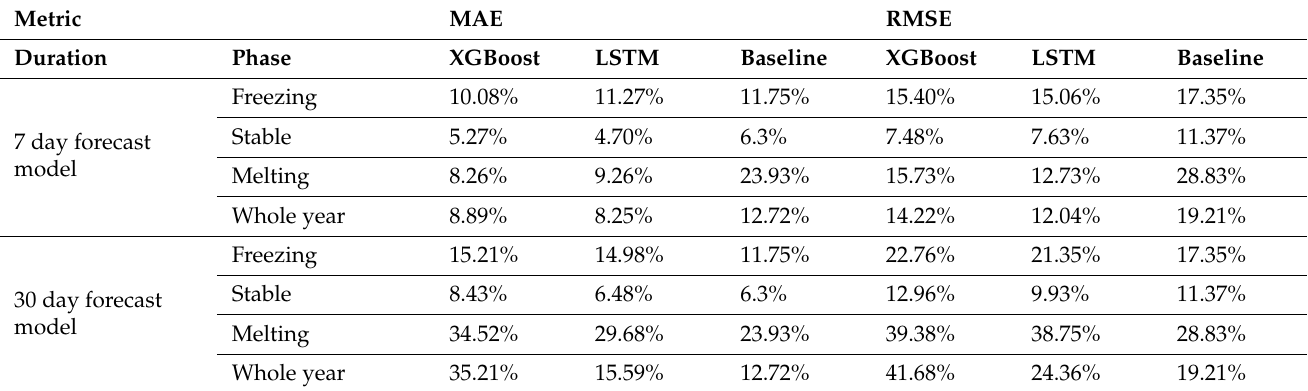
Table 4. Prediction error (RMSE and MAE) on the test set after